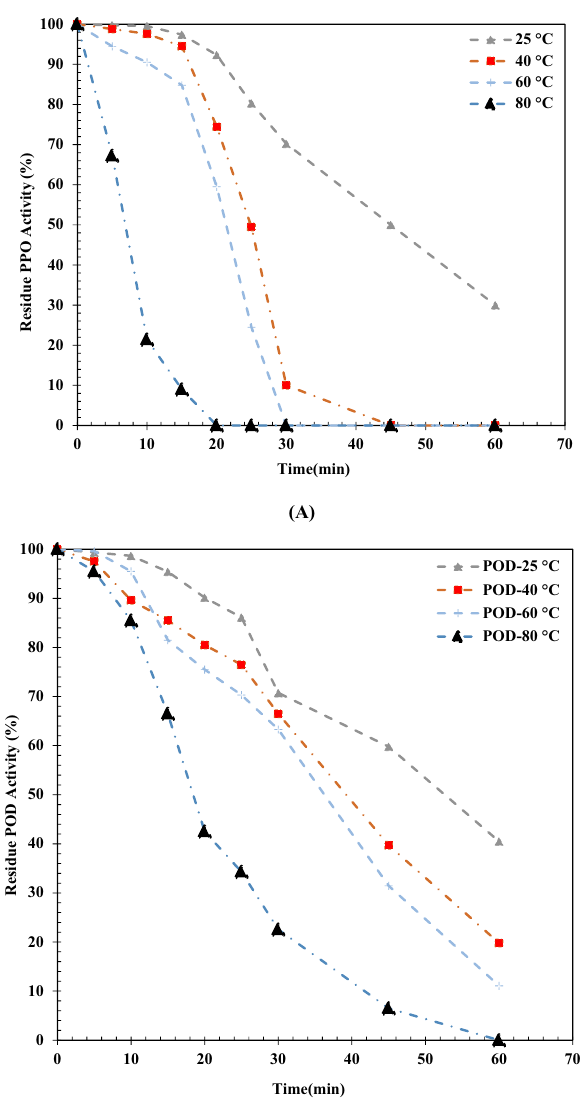
Figure 4. Heat stability of ( A ) PPO as function of time and temperature, ( B ) POD as function of time and